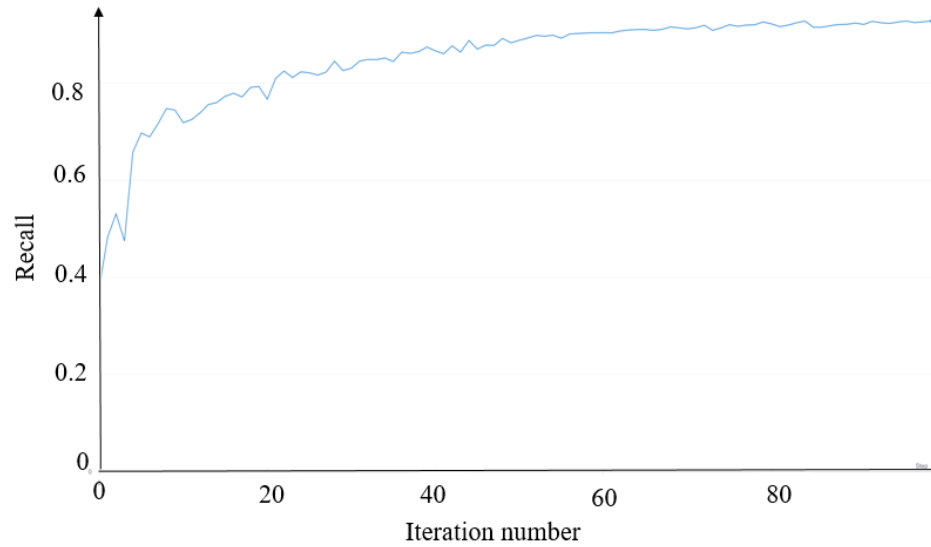
Figure 10. An example of a growing recall metric in the iteration process.